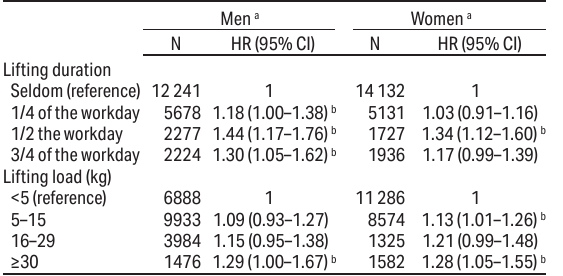
Table 4. Association between lifting duration or lifting load and risk of long-term sickness absence stratified by sex. [HR=hazard ratio; CI=confidence